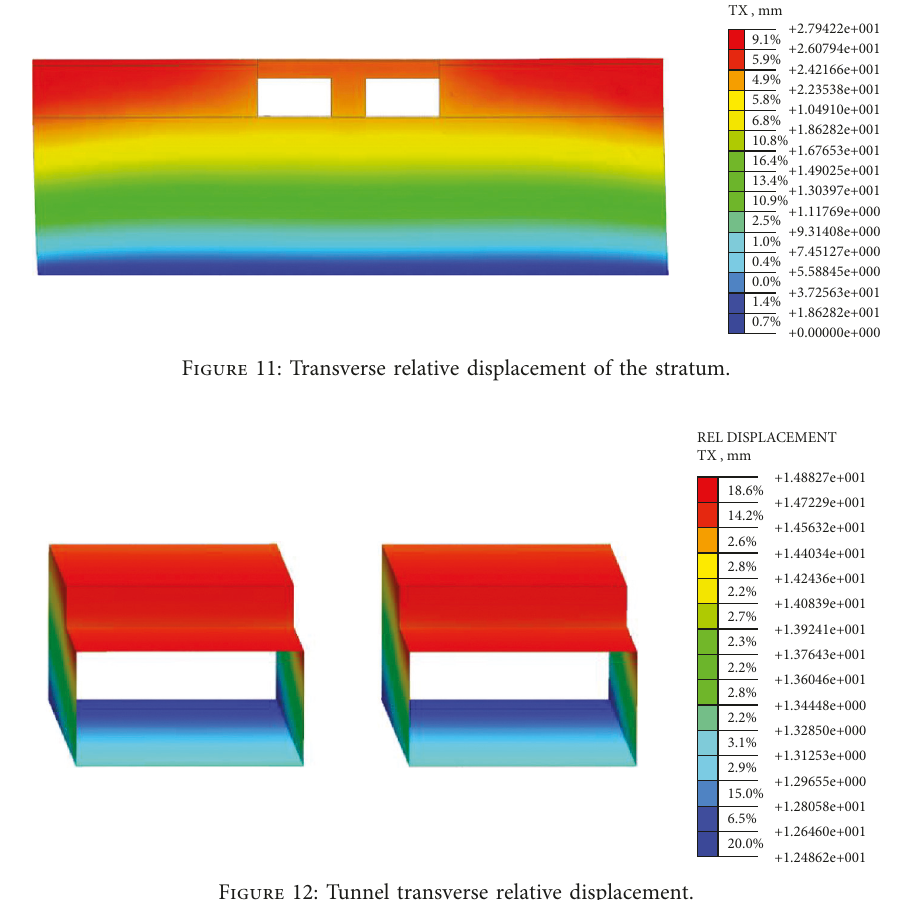
Figure 12: Tunnel transverse relative